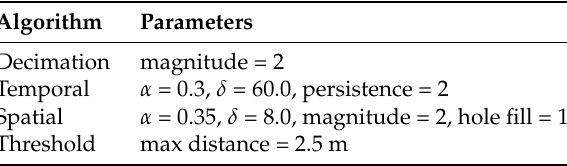
Table 6. Intel RealSense SDK Post-processing Filter